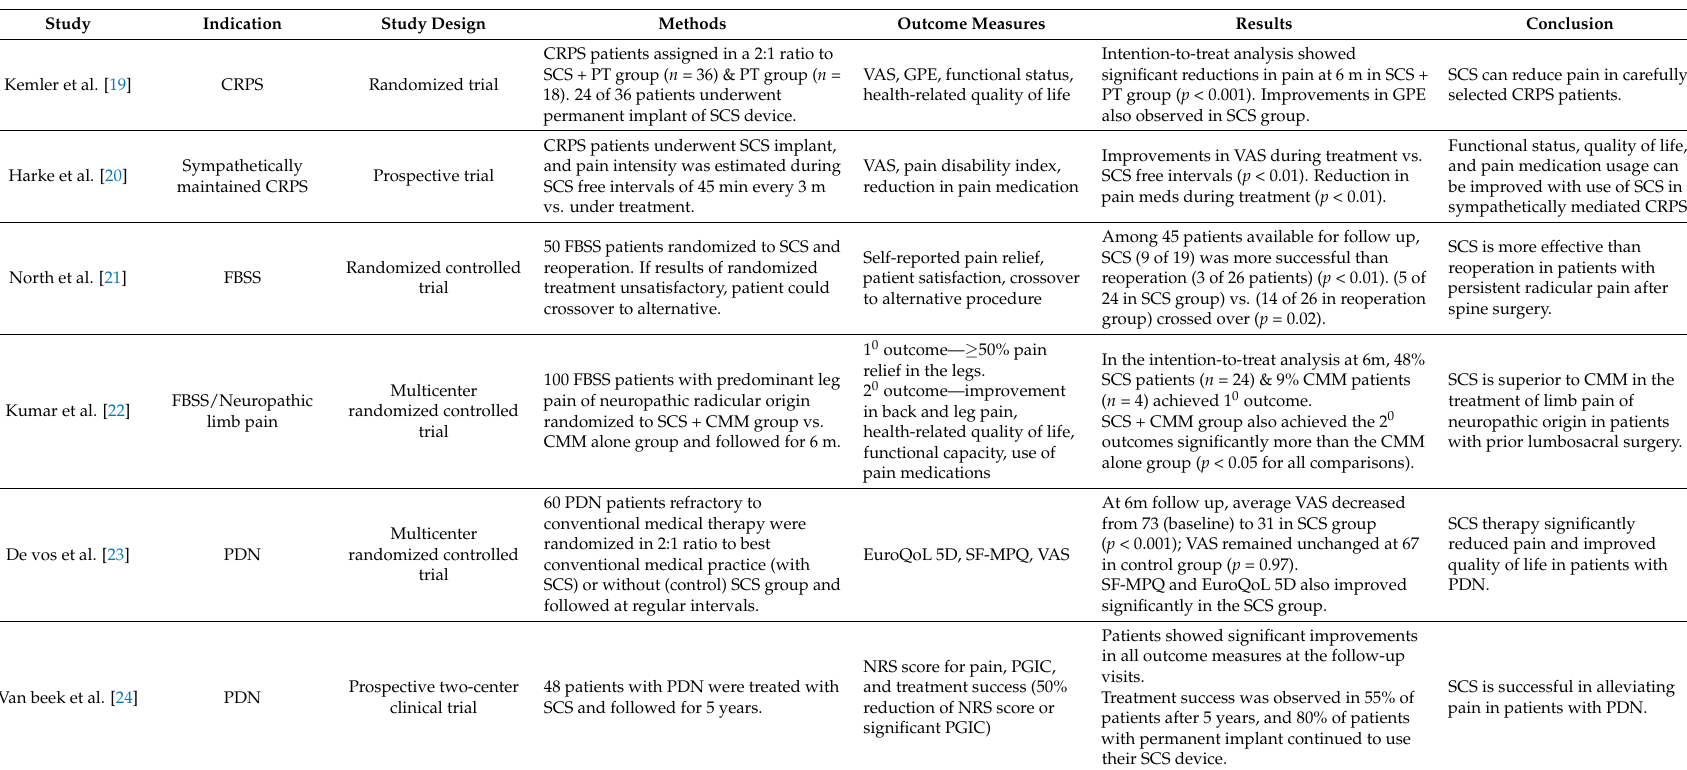
Table 1. Indications and outcomes of conventional